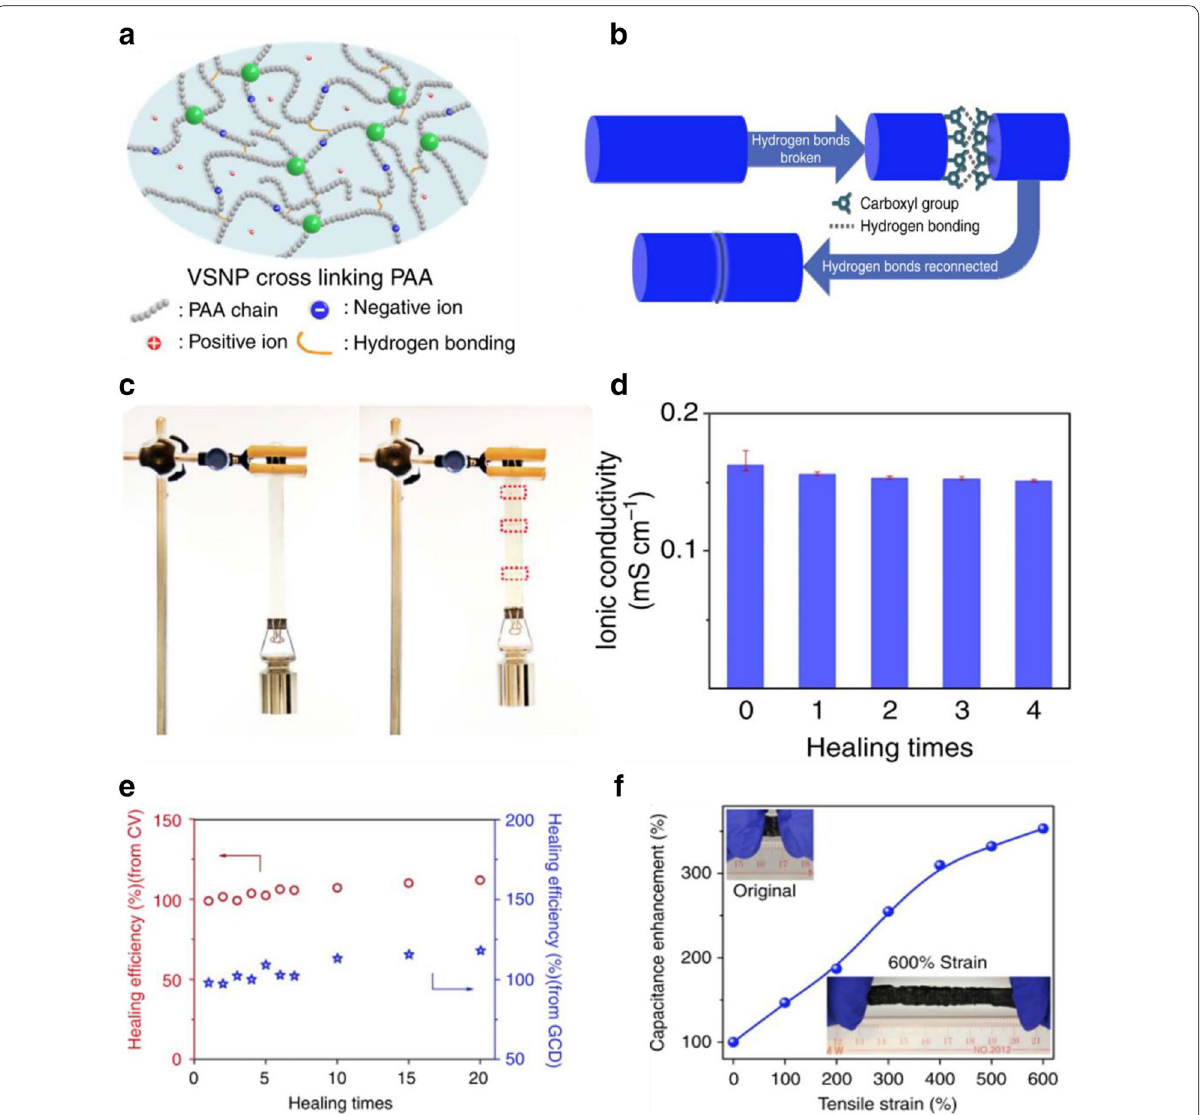
Fig. 2 a Schematic of the H-bonding and vinyl hybrid silica nanoparticles (VSNPs) dual cross-linked VSNPs-PAA electrolyte, which are intrinsically neither self-healable nor highly stretchable; b schematic of self-healing arising from interfacial coordination of carboxyl groups on the PAA. c Demonstration of the self-healed VSNPs-PAA polyelectrolyte film (3.4 mm thick 1.8 cm wide) to support ca. 500 g mass: pristine sample (left of × panel) and healed sample after the third breaking/healing cycle (right of panel); d ionic conductivity of the VSNPs-PAA polyelectrolyte after multiple healing cycles; e after healing from different cycles, the healing efficiency calculated from CV (circle, red) and GCD (star, blue) curves; f capacitance calculated from the GCD as a function of the tensile strain achieves an increase of 3.5-and 2.1-fold at 600% strain (reproduced with permission from: Ref. [38] ©2015,